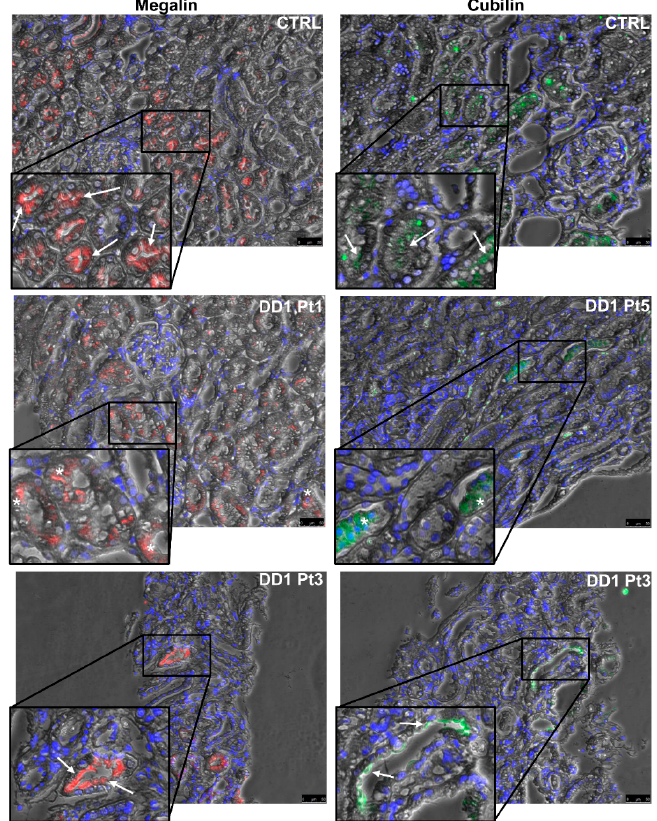
Figure 5. Megalin and cubilin immunolabeling in control and DD1 kidneys. Representative images